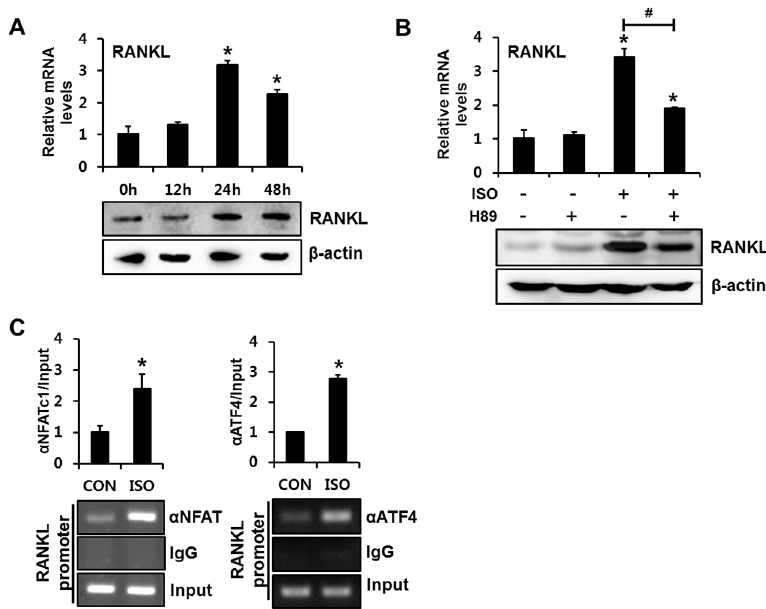
Figure 4. Isoproterenol-induced binding of NFATc1 and ATF4 to the RANKL promoter is also observed in primary cultured mouse calvarial cells. ( A ) ISO enhanced the RANKL expression levels. Calvarial cells were incubated in the presence of ISO for the indicated time periods, followed by RT-PCR and Western blot analysis. * p < 0.05, compared to 0 h. ( B ) ISO-induced RANKL expression was suppressed by inhibition of the PKA pathway. Calvarial cells were incubated in the presence or absence of ISO and H89 (20 µM) for 24 h, followed by RT-PCR and Western blot analyses. * p < 0.05, compared to CON. # p < 0.05, compared to ISO alone. ( C ) ISO increased the binding of NFATc1 and ATF4 to the mouse RANKL promoter. Calvarial cells were incubated for 24 h with ISO and the chromatin immunoprecipitation assay was performed with the indicated antibodies. Statistical significance was determined using one-way ANOVA. * p < 0.05, compared to CON.